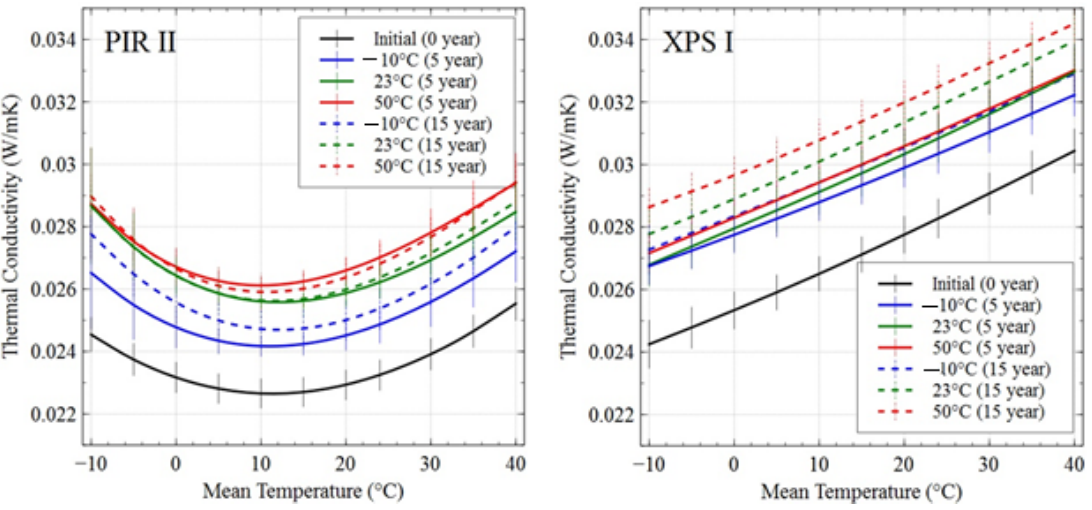
Figure 6. Temperature dependent thermal resistance measured at the equivalent of 0, 5, and 15 years of aging at − 10, 23 and 50 ◦